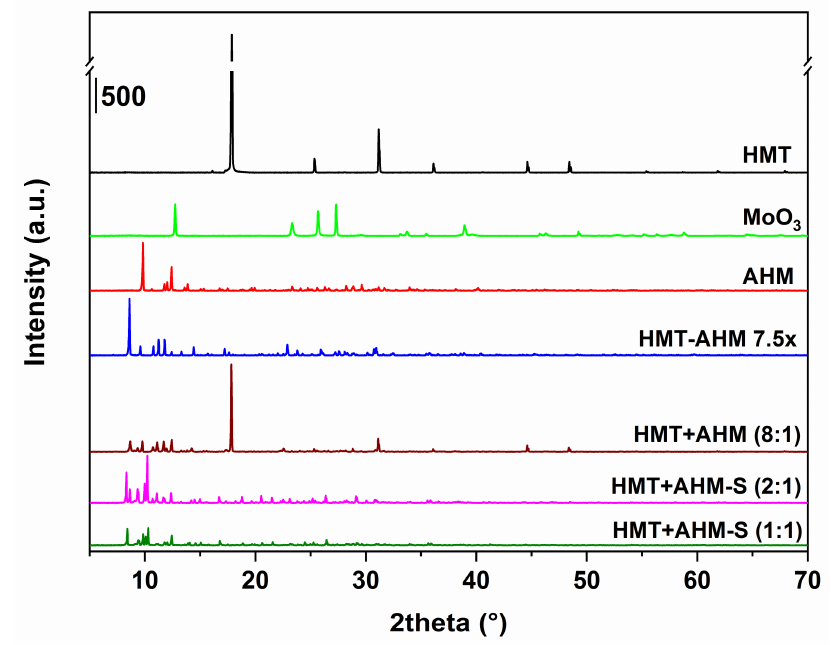
Figure 2. X-ray diffraction patterns of the synthesized precursors and the starting